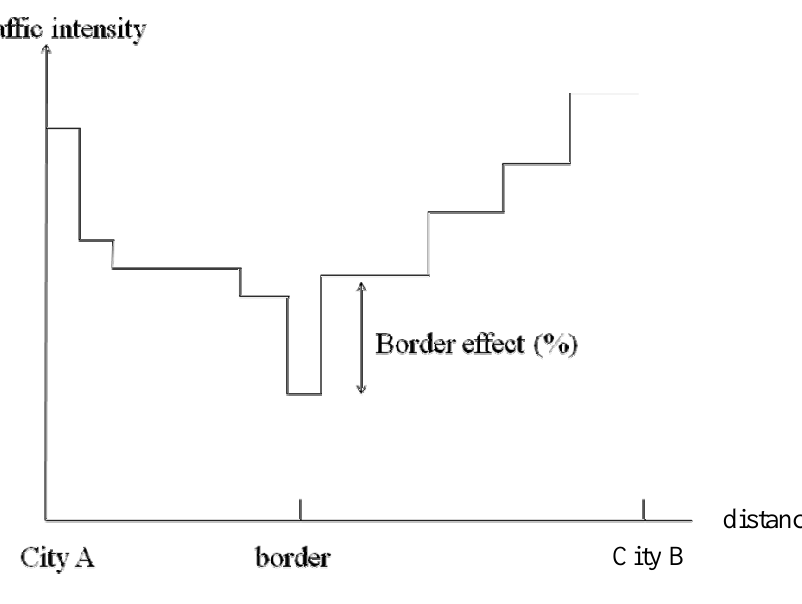
Figure 2. Border effect measured by means of traffic intensities at an international link between city A and city